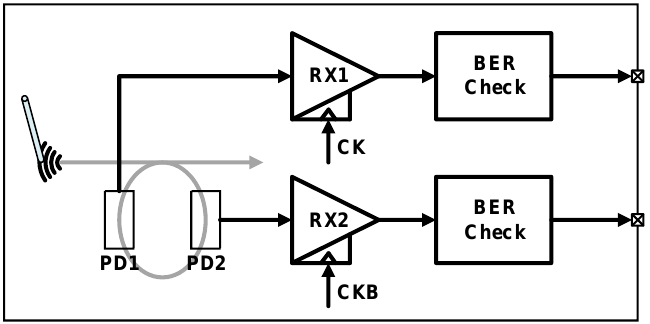
Figure 7. Monolithic receiver with PD splitting [46].